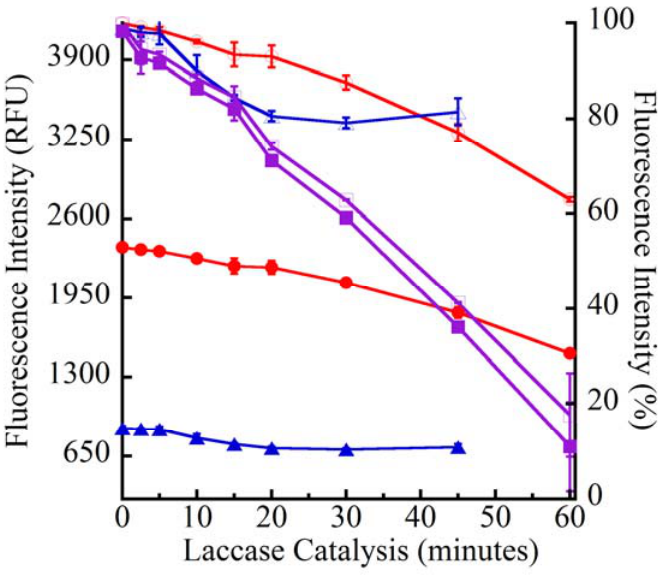
Figure 5. Laccase pseudo -kinetic oxidation of CA. Laccase (0.1  g/mL) was used to oxidize 500  M CA in pH 4.5 buffer in 96-well UV-transparent microplate. Identical reaction sets were stopped at the indicated time points using base (100 mM NaOH). The CA samples were then excited using 290 nm wavelength and the emission was monitored at 416 nm. The CA samples analyzed were purchased from Alfa Aesar (open and closed triangles, blue tracings), Acros Organics (open and closed circles, red tracings) and Sigma- Aldrich (open and closed squares, purple tracings). Open symbols represent percent decrease in fluorescence intensity and closed symbols are fluorescence intensities